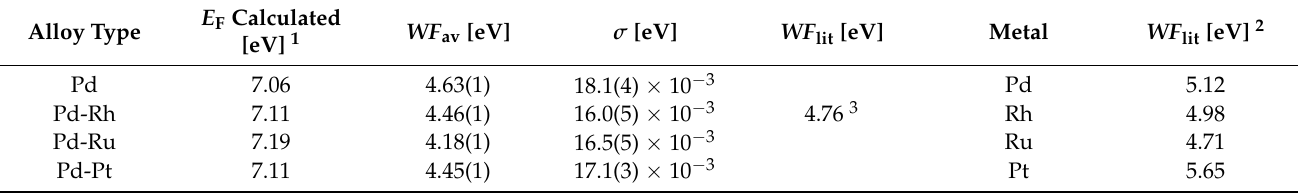
Table 4. Theoretical values of the Fermi level energy ( E F ) of the electrodeposited Pd and Pd-binary alloys and average work function ( WF av ) and standard deviation ( σ ) calculated using histograms shown in Figure 4a–d ( WF av ) as well as work function taken from the literature for alloys and pure metals ( WF lit